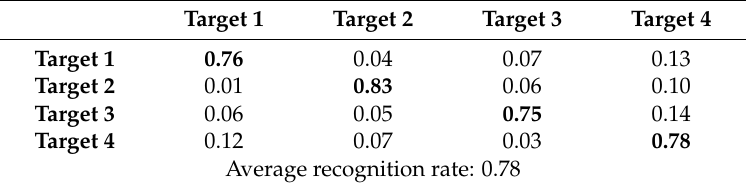
Table 8. Real data recognition result for the SSM-OMP method without LSVs.